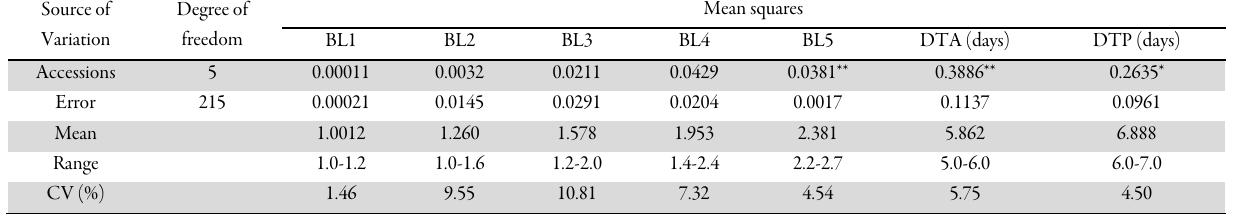
Table 2. Analysis of variance summary of six floral morphological traits